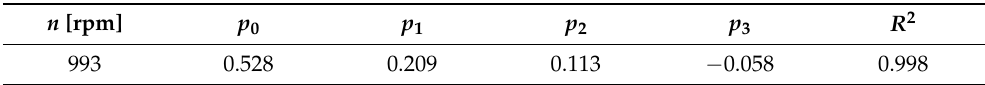
Table 8. The coefficients of the 3rd-degree polynomial approximation function for the mechanical power P m = f ( Q ) of the 1MW Worthington pump at speed of 993 rpm.